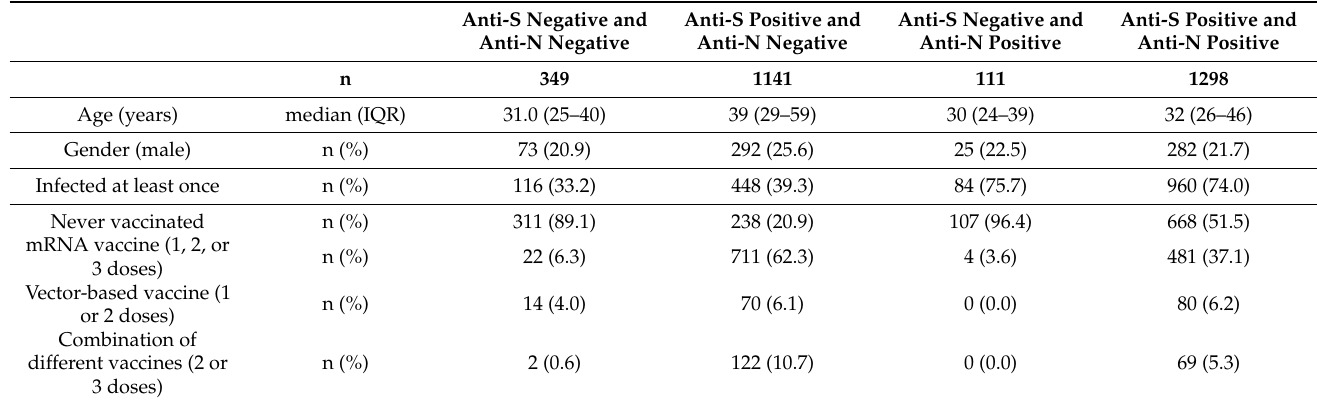
Table 3. Demographic data, vaccination history, and data on previous infection with SAS-CoV-2 stratified according to anti-S and anti-N antibodies